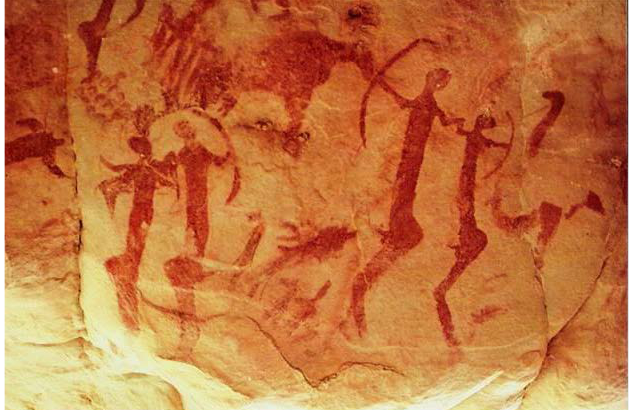
Figure 10. Aounate Azguer rock-shelter (photo Searight).